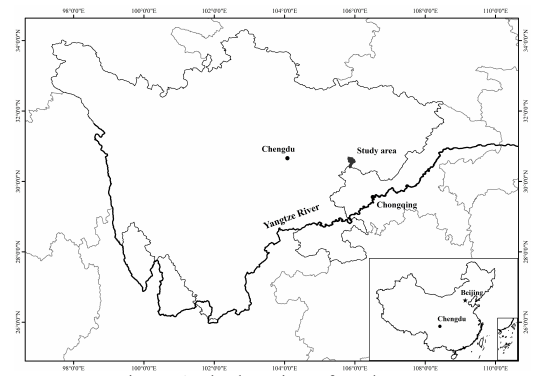
Figure 1 The location of study